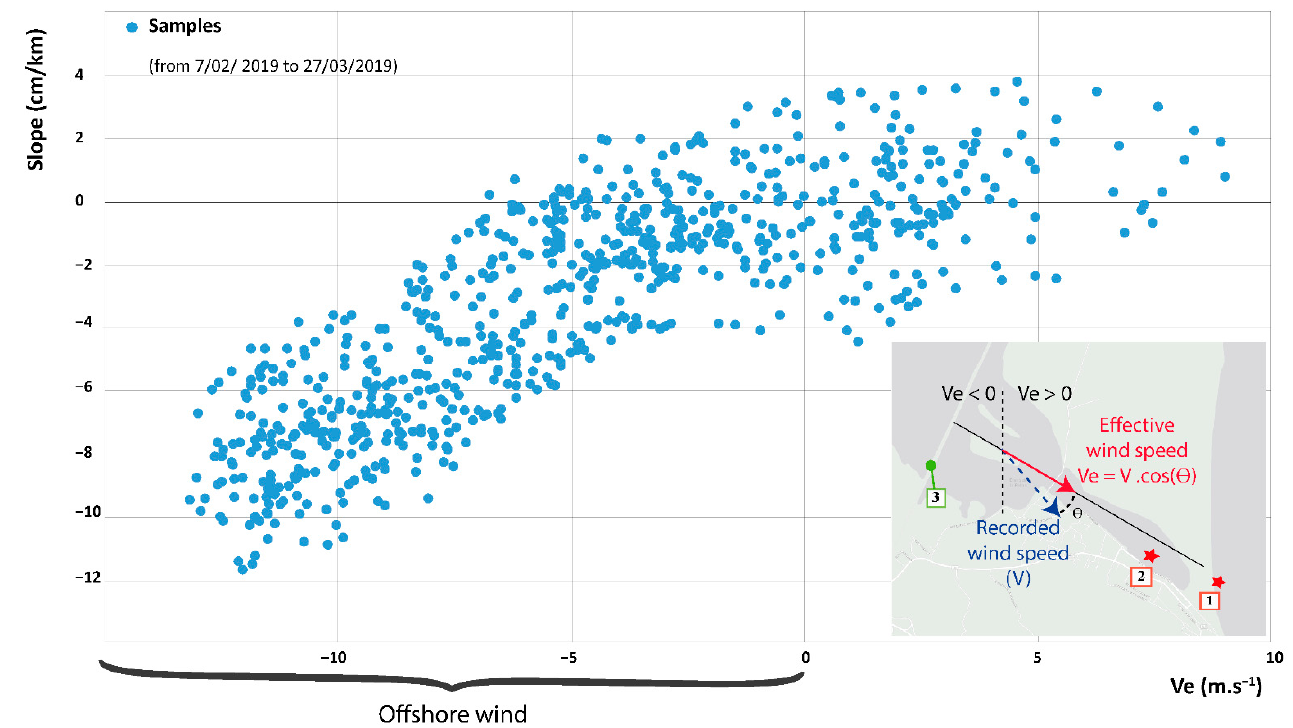
Figure 4. Recorded hourly lagoon surface slope versus effective wind speed (Ve). Ve > 0 for onshore forcing and Ve < 0 for offshore forcing, where Ө is the angular difference between the recorded wind direction and the reference axis parallel to the Grazel (between sensors 2 and 3).